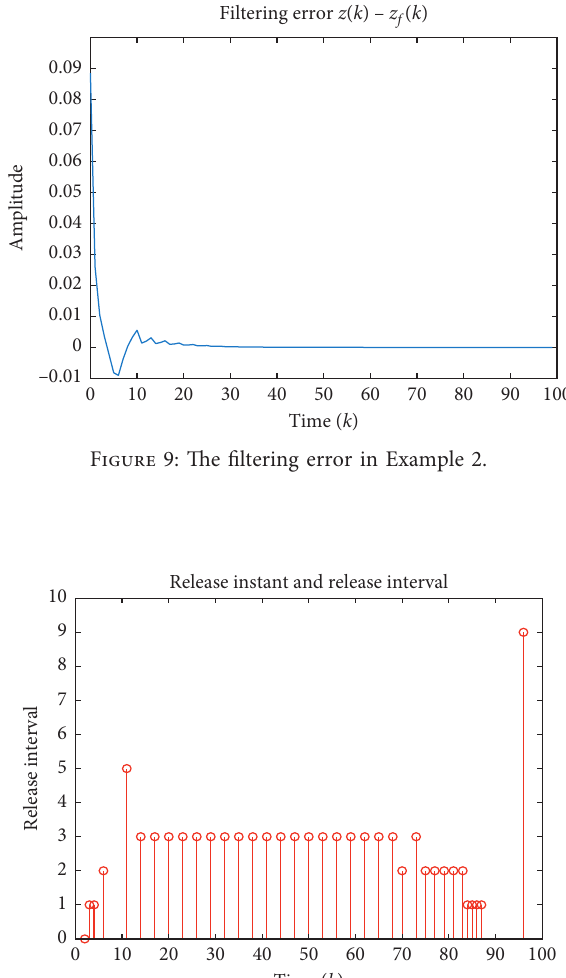
Figure 7: The release instants and their interval in Case 2.